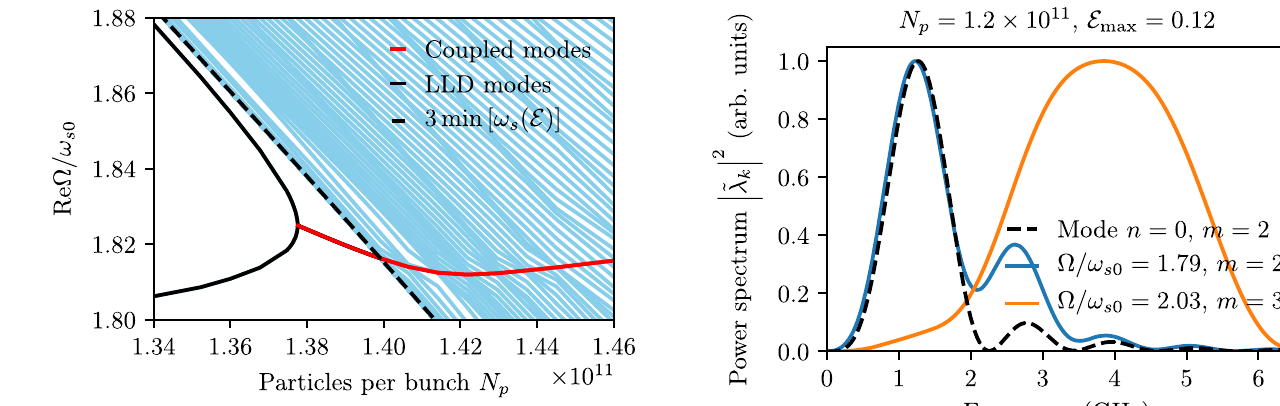
¼ 0 . 12 . Solid max